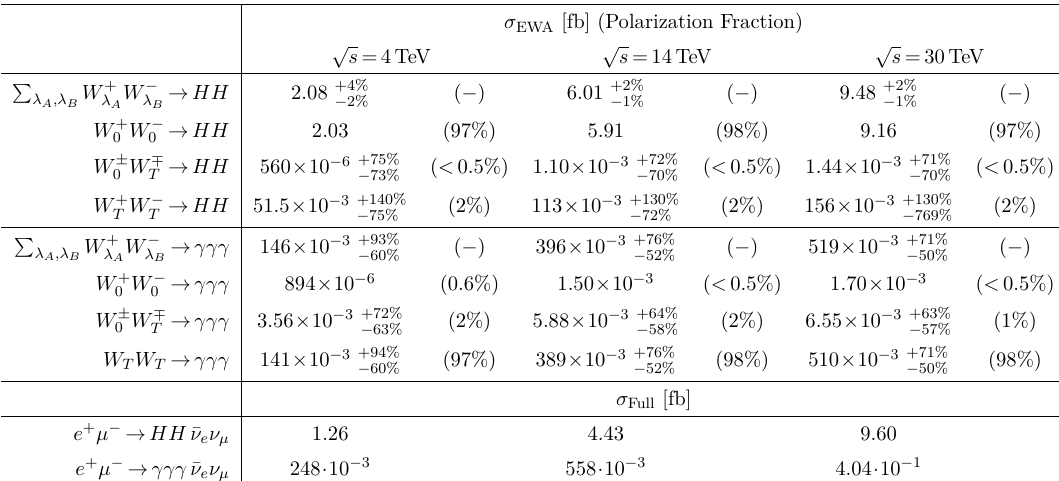
Table 2 . Upper: unpolarized and polarized, EWA-level cross sections [fb] for the process W + HH , with scale uncertainties [%] and polarization fractions [%] , in e + µ − collisions at and 30 TeV. Middle: the same but for the process W + of eq. (4.4). Lower: the cross sections for the analogous processes using the full 2 → 4 or 2 → 5 ME. No restrictions are applied to the invariant masses M ( HH ) and M ( γγγ )